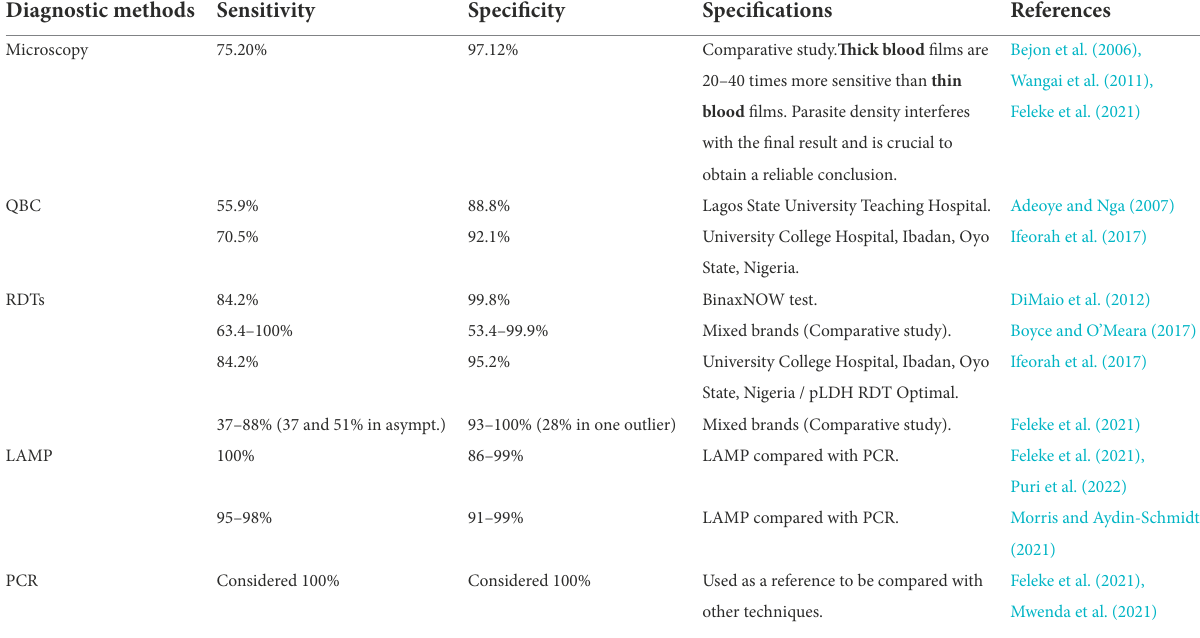
TABLE 2 Sensitivity and specificity of malaria diagnostic